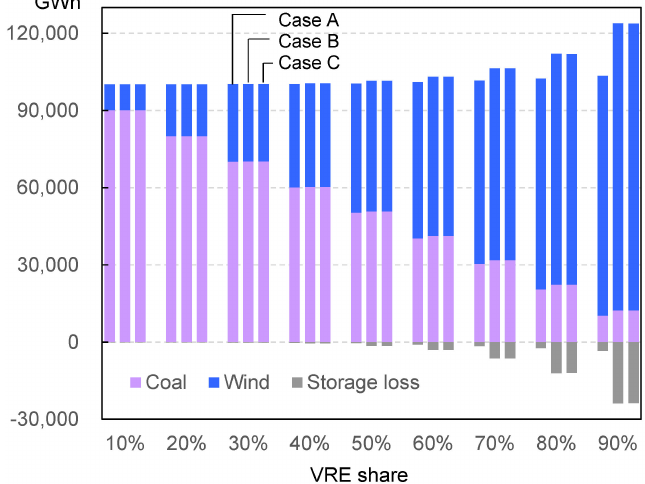
Figure A2. Total power generation by